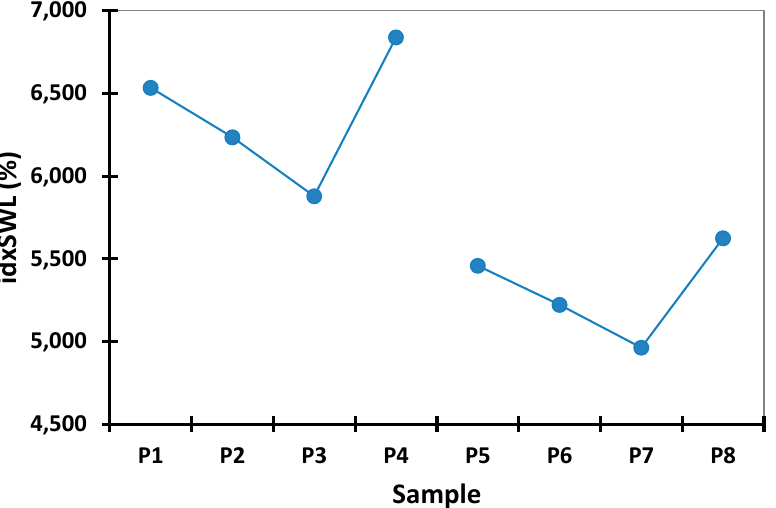
Figure 6. Interval plots of the swelling index (idxSWL (%)) of the microspheres for Sample factor levels.